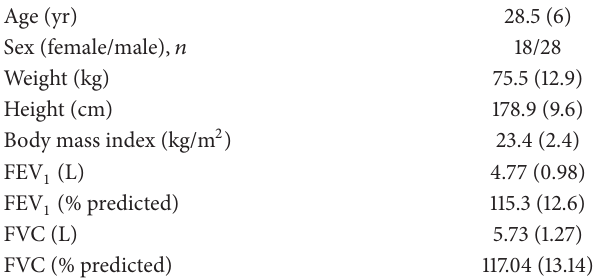
Table 1: Mean (SD) baseline characteristics of